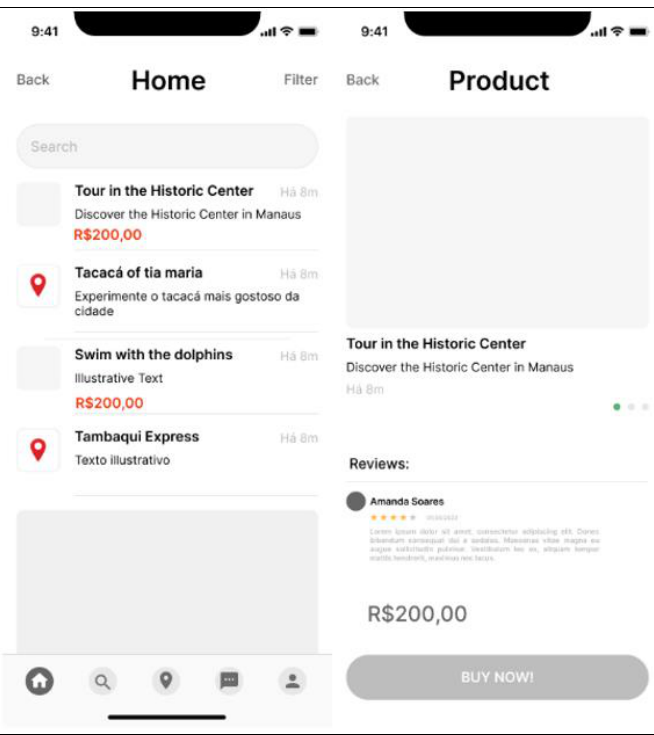
Figure 5: Home screens and product details and purchase.